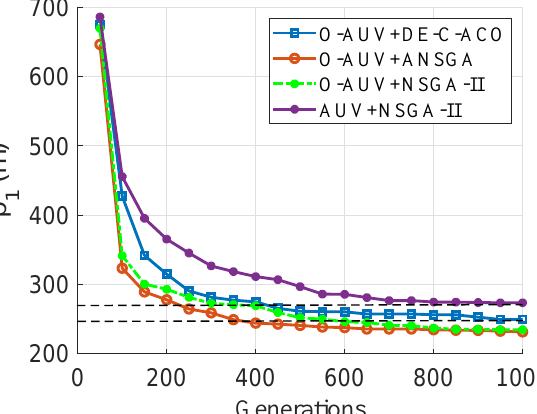
Figure 16. Comparison of the evolution curves of different